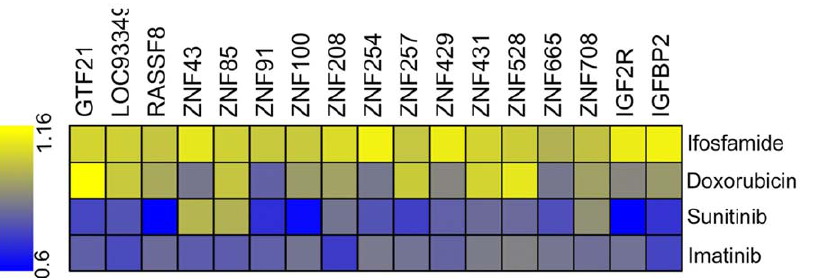
Figure 3. Heatmap showing sensitizing index (SI) ranging from 0.6 (blue) to 1.16 (yellow). Sensitization was tested in GIST T1 cells in the presence of four drugs including separately: Ifosfamide (top), Doxorubicin (second row), Sunitinib (third row) and IM (bottom). SI values on log scale are plotted.